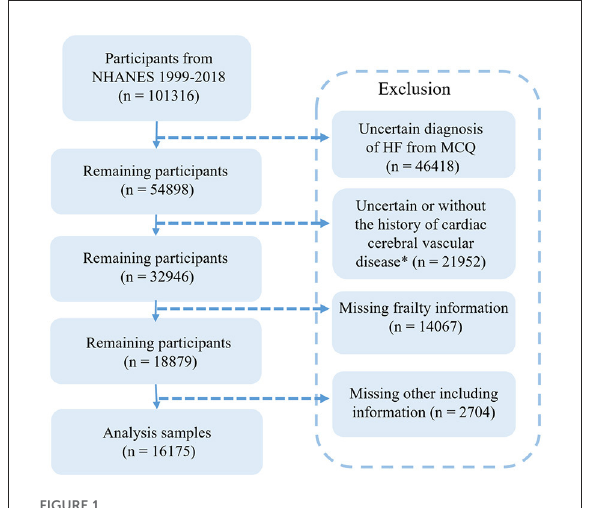
FIGURE1 Flow chart of the screening process for the selection of eligible participants in NHANES